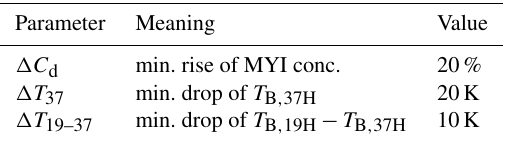
Table 3. Tuning parameter settings for the drift correction